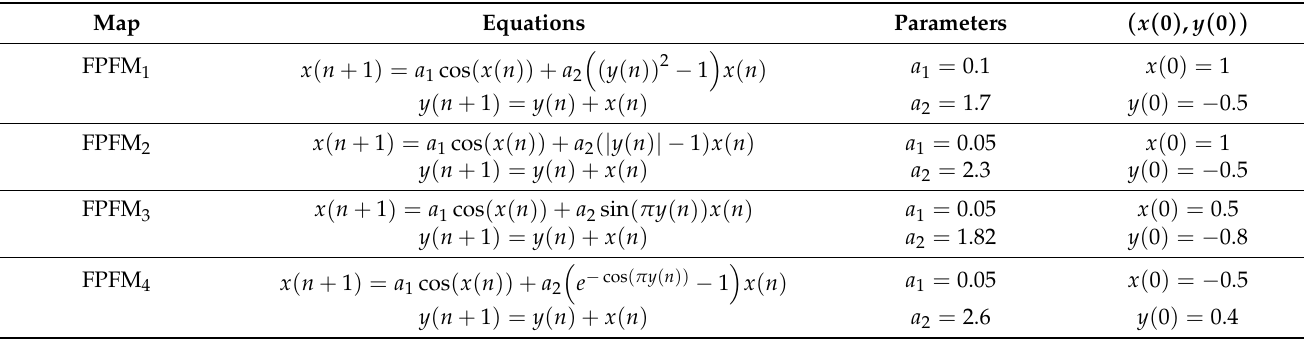
Table 1. Fixed point-free maps derived from the general model.